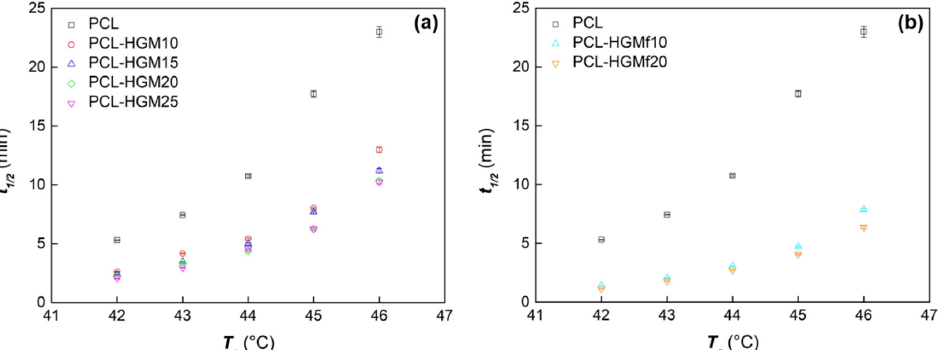
Figure 3. Half-time of crystallization vs. the crystallization temperature (average values with standard deviation) for PCL and composites PCL-HGM ( a ) and PCL-HGMf ( b ).